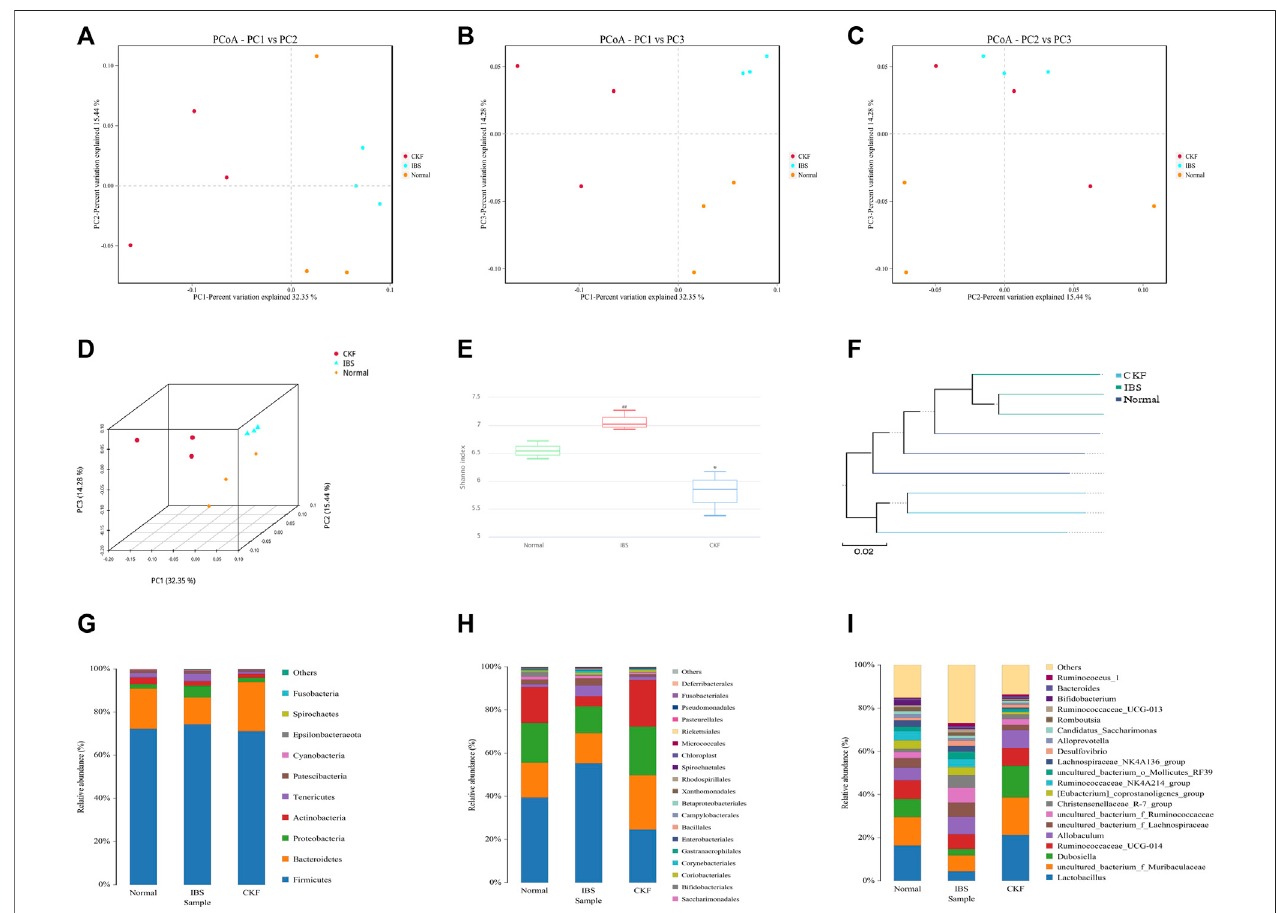
FIGURE7| Responsesofthediversity,richness,andstructureofthegutmicrobiotatoCKFinIBSrats. (A – D) BinaryJaccard-basedPCoA. (E) Shannonindex. (F) BinaryJaccardclustertreebasedonUPGMA. (G – I) Relativeabundancesofthegutmicrobiota atphylum,order,andgenuslevels. Valuesarepresented asthemeans± SD ( n = 3). ## p < 0.01 compared to Normal, * p < 0.05 compared to IBS.